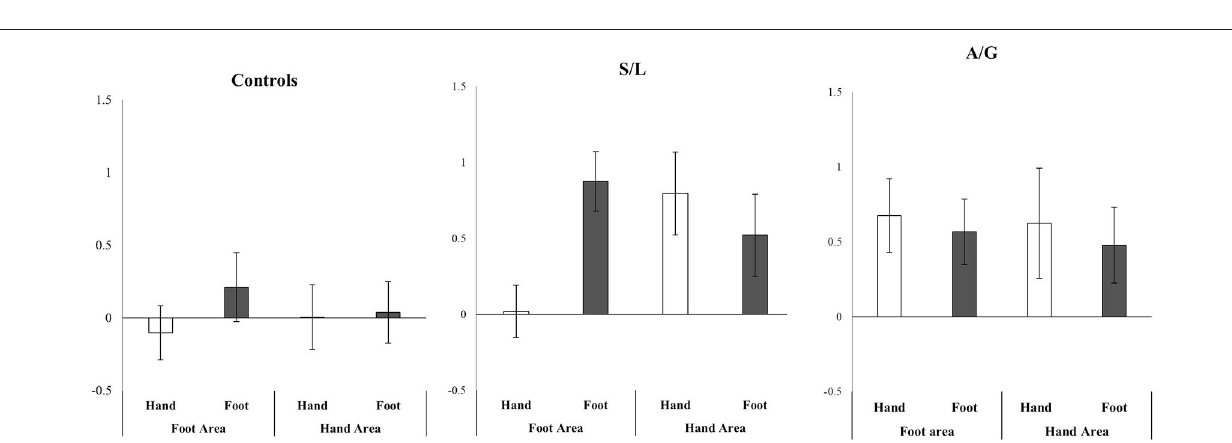
FIGURE 6 | Relative activity in SI hand and foot areas (Pain > No-Pain) depending on whether a hand or foot stimulus was shown. Only the S/L group show an interaction between region X stimulus. Error bars show ± 1